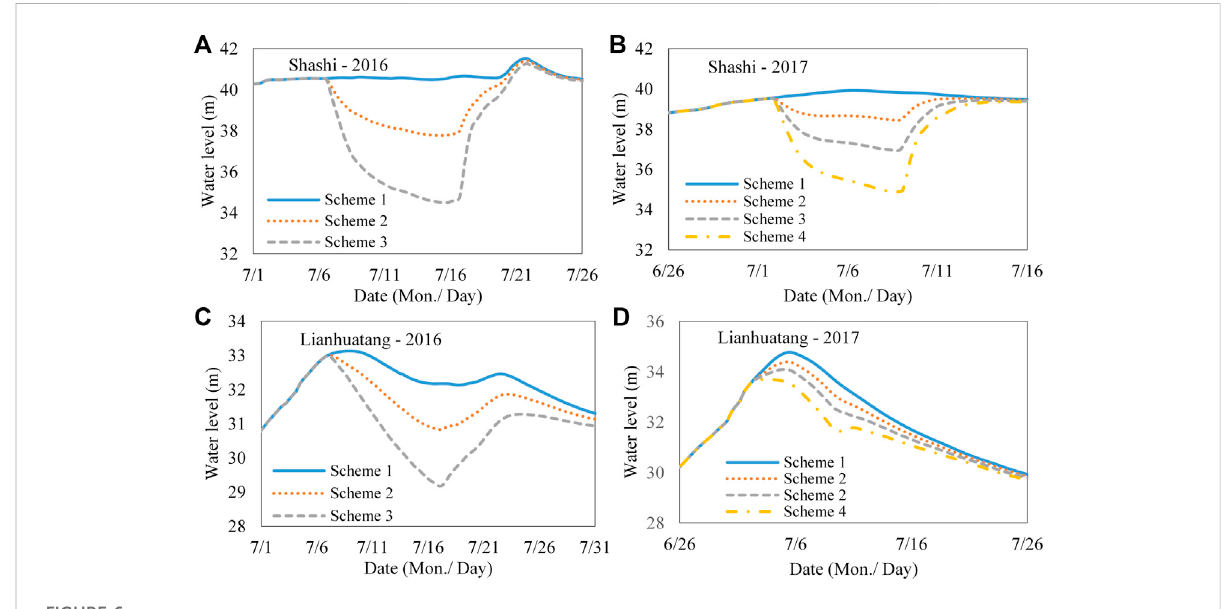
FIGURE 6 The water level processes under different fl ood interception discharges during the same period: (A) Shashi — 2016; (B) Shashi — 2017; (C) Lianhuatang — 2016; (D) Lianhuatang —